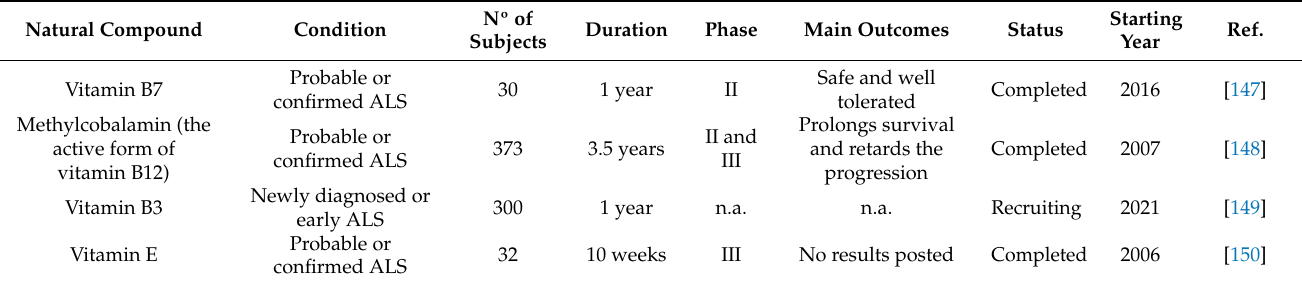
Table 4. Natural compounds in clinical trials for ALS